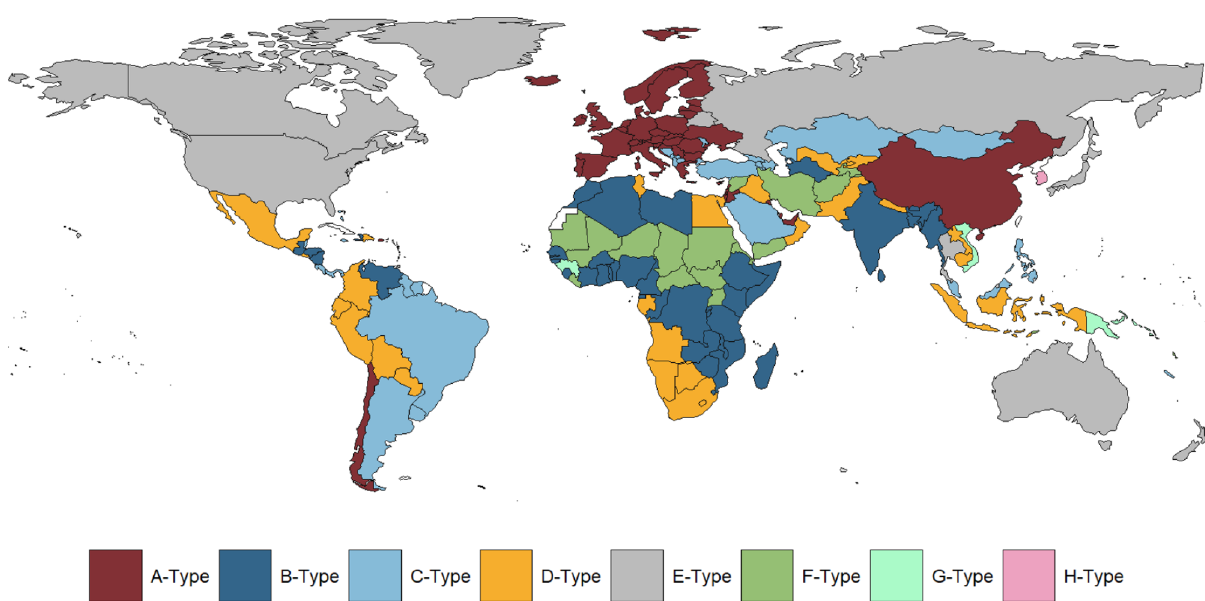
Figure 6. Global cluster membership on the basis of a combination of HPC (hours of playtime per capita), MDP (minutes of daily playtime per active user), and PI (playtime inequality). Map was generated using ggplot in R (v4.0.2). Code for reproducing these maps is available at the OSF repository associated with the